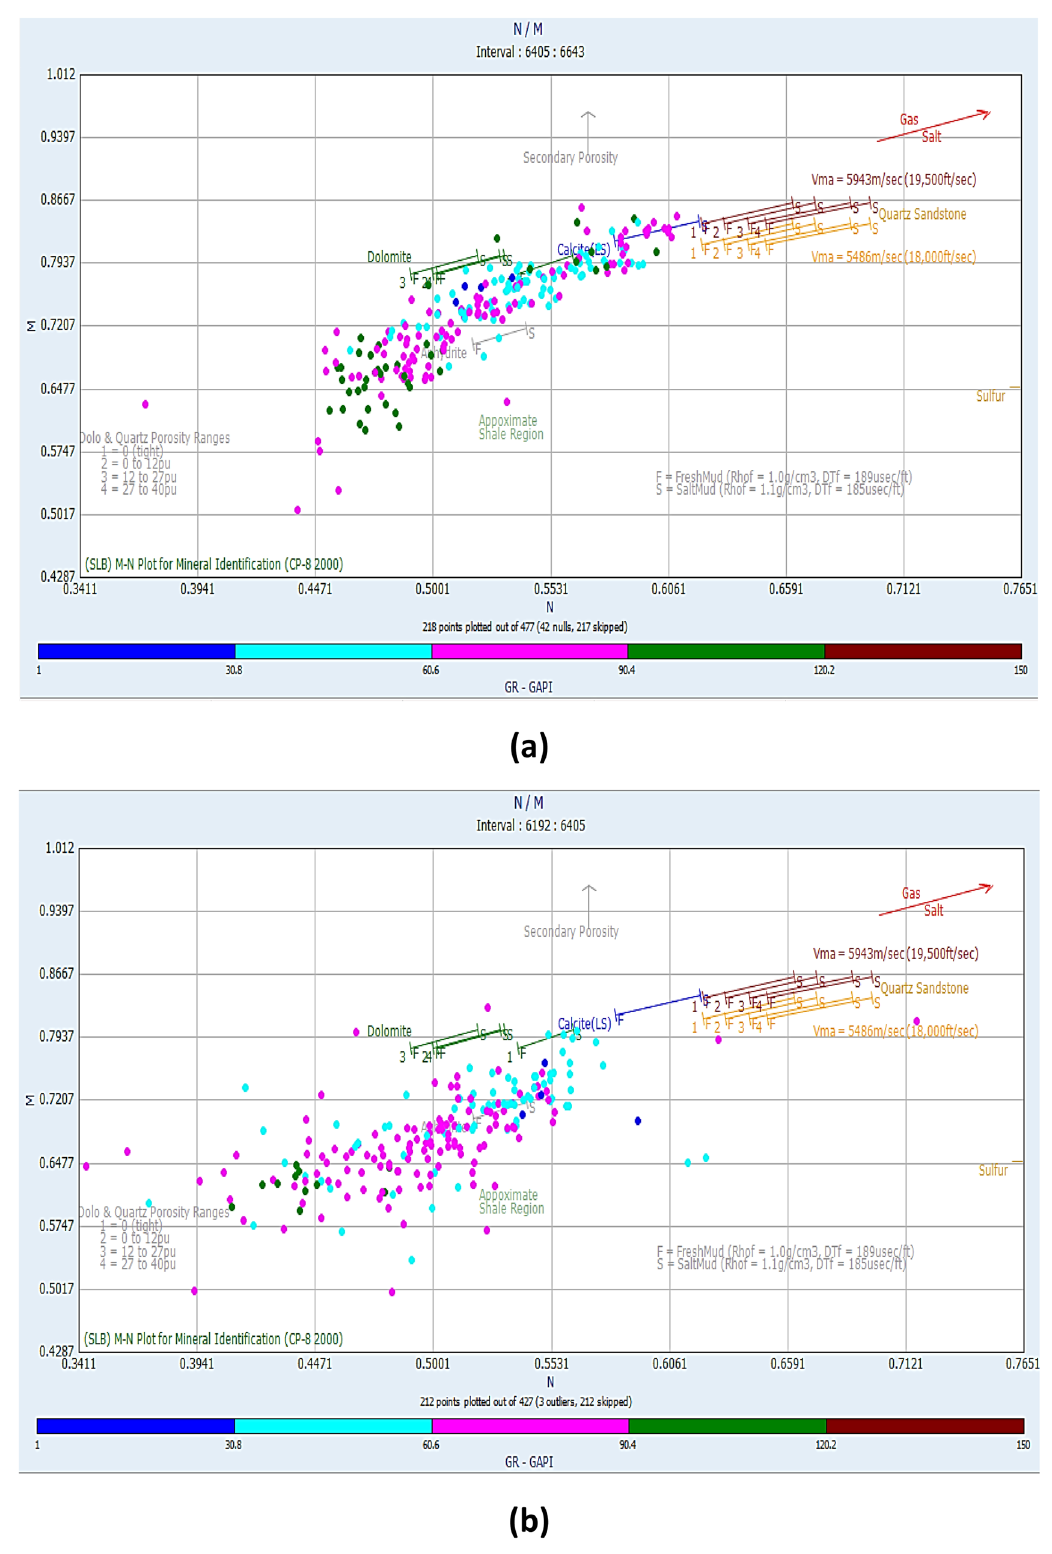
Fig. 18 M–N cross-plots for a the Lower Bahariya Member, and b the Upper Bahariya Member in Kh_56